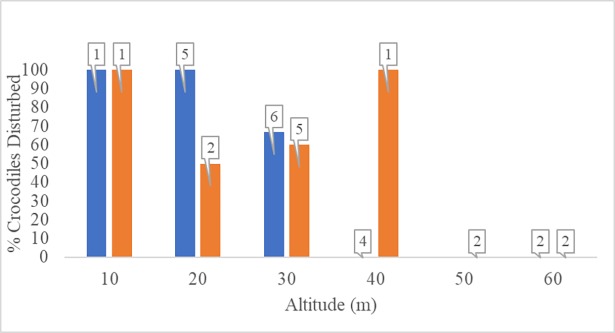
Drone disturbance to crocodiles by habitat.The percentage of crocodiles (Crocodylus posorus) that were disturbed by the presence of a drone while resting on the beach or in the surf (orange bars), or actively swimming in nearshore waters (blue bars) at Bare Sand Island, Northern Territory, and Cape Domett, Western Australia. The numbers of total crocodiles sampled for each altitude are show in boxes above the bars.